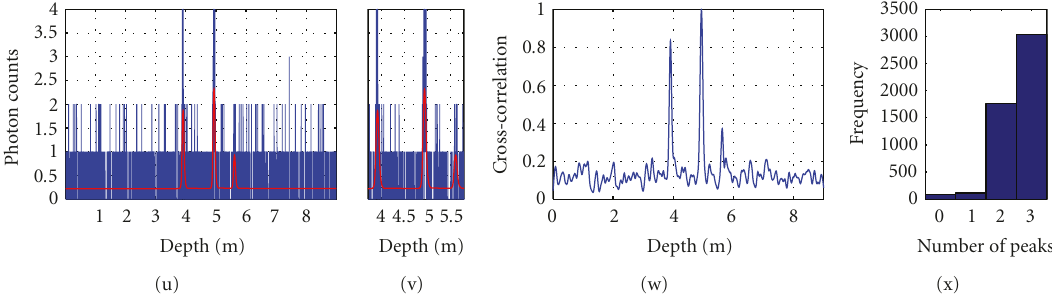
Figure 7: Comparison of ladar signal analysis for the concealed mannequin using RJMCMC and cross-correlation. The first column shows the raw data and the posterior parameter estimates from the RJMCMC method, while the second column gives the magnified plot of the signal peaks. The third column shows the cross-correlation function. The right hand column shows the posterior probability estimate of the number of surface returns, p ( k | y ).